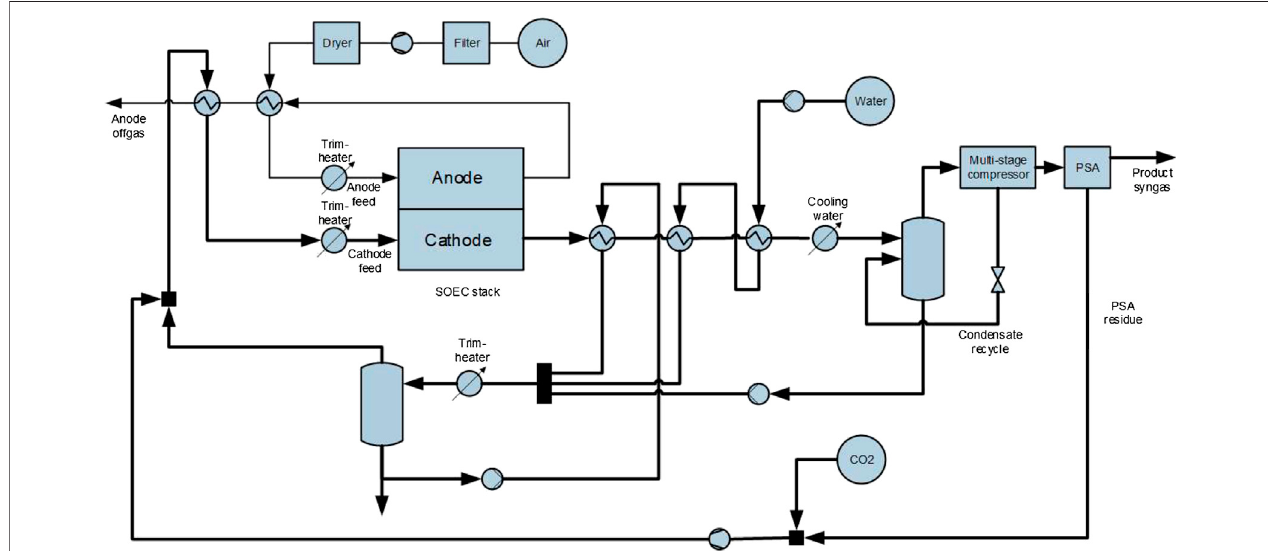
FIGURE 2 | Simpli fi ed process fl ow diagram of HT-co-electrolysis.